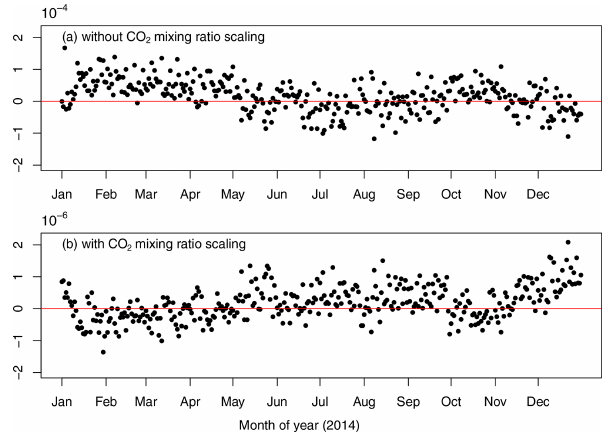
Figure 3. Variation of global CO 2 mass as the ratio to its value prior to a meteorological re-initialization during a 1-year MPAS-A sim- ulation with meteorological re-initializations at 24h intervals. The top panel is from the simulation without applying CO 2 mixing ratio scaling as described in Sect. 3.2.2, and the bottom panel is from the simulation with the scaling. In each figure, the x axis represents the days of 2014 and the y axis the ratio of global CO 2 mass variation to its value prior to a meteorological